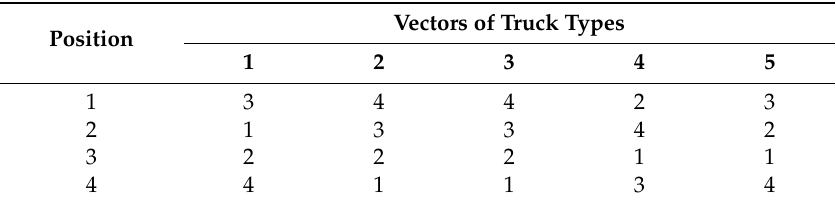
Table 4. Positions of initial vectors of truck types.